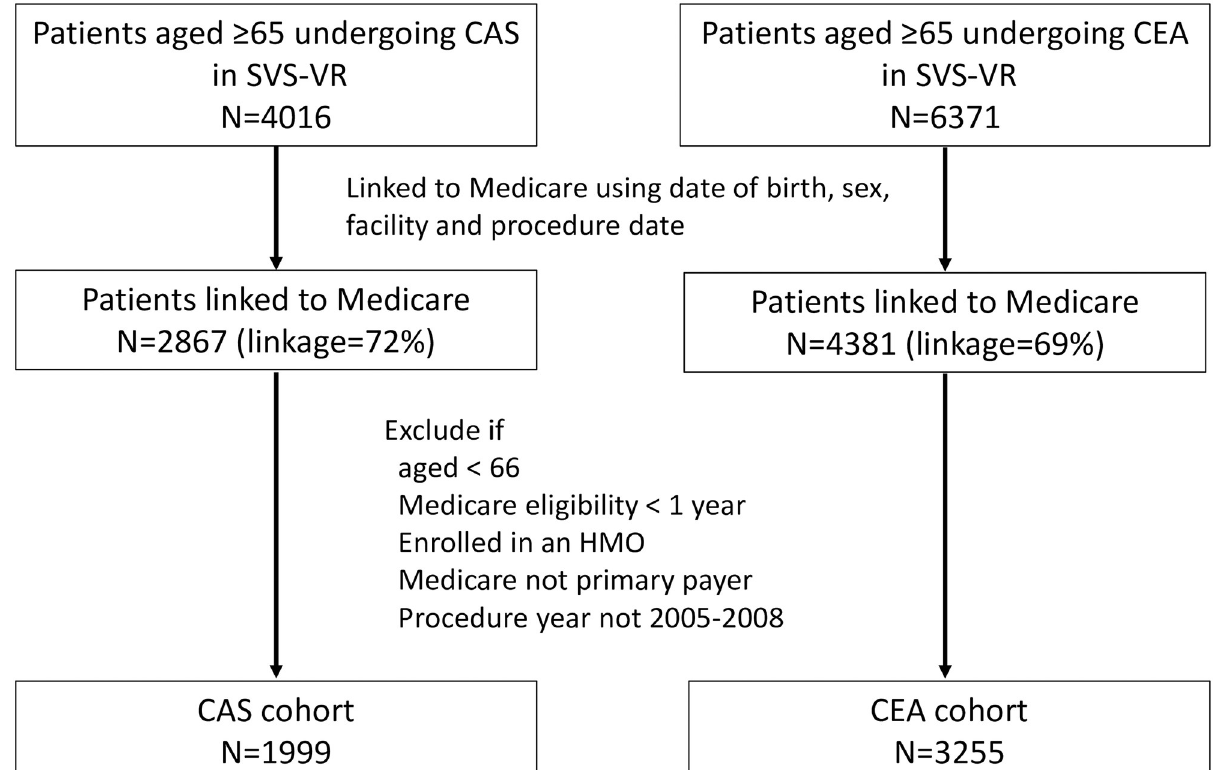
Fig 1. Flow chart for creation of Medicare-linked SVS-VR CAS and CEA study cohorts. Abbreviations: CAS = Carotid stenting; SVS-VR = Society of Vascular Surgeons Vascular Registry; CEA = Carotid endarterectomy; HMO = Health maintenance organization.